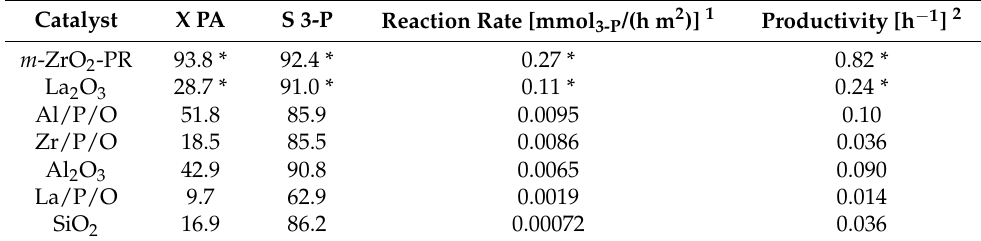
Table 2. Catalytic activity of metal oxides and metal phosphates for the ketonization of PA to 3-P in the reaction condition of Figure